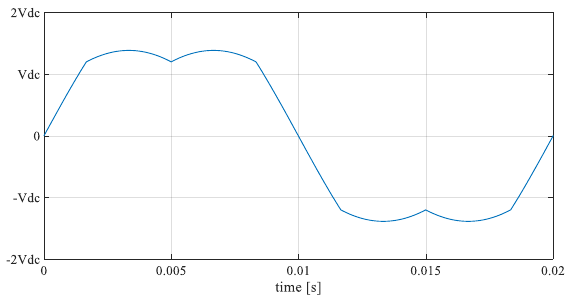
Figure 4. Third Harmonic Injection (THI) modulating signal. Figure 5. SFO (Switching Frequency Optimal) modulating signal.